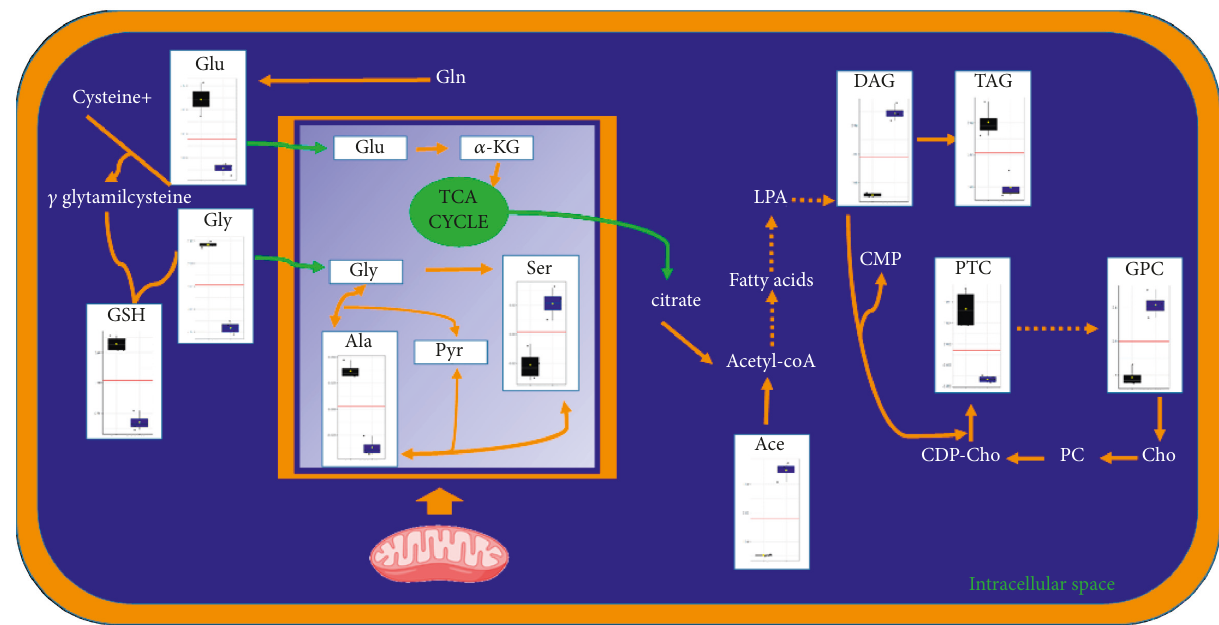
Figure 8: Schematic biochemical representation of the main metabolic pathways altered at six hours after Pt-EtOMeSOphen treatment. Box plots show the trend of highly significant altered metabolites ( p value < 0.01). Black: control cells; blue: Pt-EtOMeSOphen. Glu: glutamate, Gly: glycine, GSH: glutathione, α -KG: alpha-ketoglutarate, Ala: alanine, Pyr: pyruvate, Ser: serine, Ace: acetate, LPA: lysophosphatidic acid, DAG: diacylglycerol, TAG: triacylglycerol, PTC: phosphatidylcholines, GPC: glycerophosphocholine, Cho: choline, PC: phosphocholine, CDP-Cho: cytidine diphosphocholine.